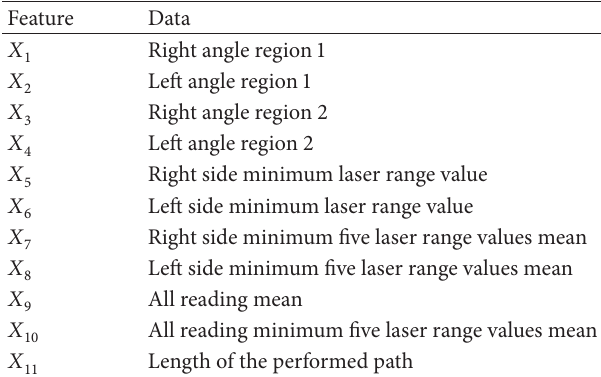
Figure 3: The angle areas used for data collection. Table 1: Collected